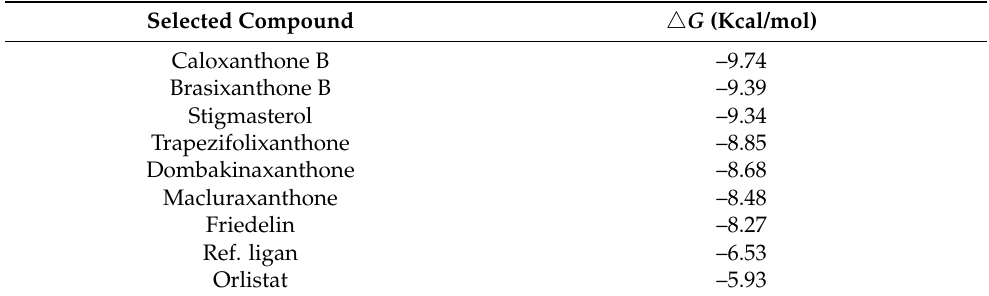
Table 5. Result of molecular docking of selected compounds in Calophyllum soulattri to fat mass and obesity-associated protein (FTO).